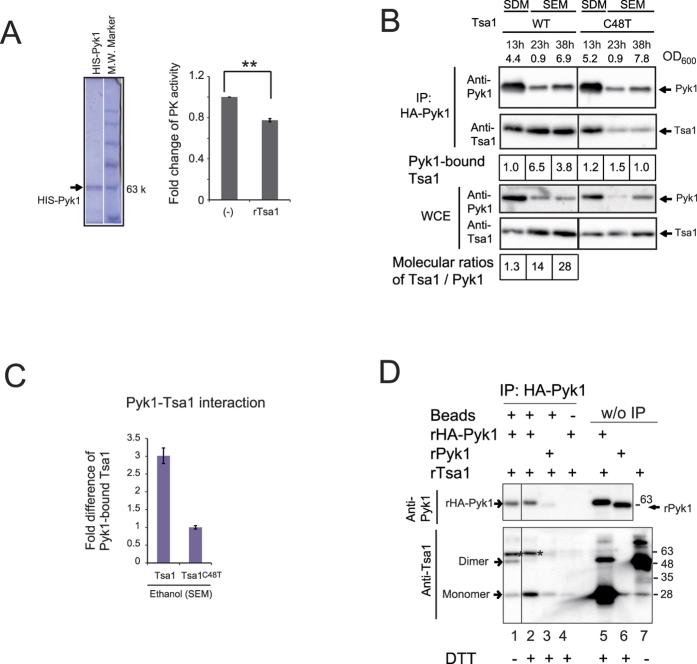
Tsa1 can bind to Pyk1 in cells during gluconeogenesis, and this interaction decreases PK activity.(A) The PK activity of purified HIS-tagged Pyk1 from yeast cells (approximately 0.8 μg), the quality of which is presented in the left panel (Quick-CBB staining), was repressed by the addition of recombinant Tsa1 (rTsa1, 1.0 μg). The fold changes in PK activity (N = 4) are reported, with error bars representing the standard error of the mean (right). “**” indicates p values of 0.0008. (B) A pull-down experiment of Tsa1 bound to HA-Pyk1. Cells expressing HA-Pyk1 and wild type Tsa1 (WT) and Tsa1C48T (C48T) were grown to the exponential phase in SDM and SEM –Trp. Cells were collected at the indicated times and cell densities (OD600; the maximum cell density in SEM was approximately 14). Immunoprecipitates and whole cell extracts (WCE) were fractionated by SDS-PAGE with DTT in sample buffer and immunoblotting. The fold differences in the levels of Pyk1-bound Tsa1 or Tsa1C48T are indicated. The molecular ratio (1.3) of Tsa1 to Pyk1 in cells growing exponentially in SDM is indicated in the data shown in Fig. 3D 32; in cells growing in SEM, this ratio was estimated by comparing the levels of Pyk1 (Tsa1) in WCE. (C) The fold difference in Tsa1 bound to Pyk1 was compared to that of Tsa1C48T. Multiple samples (N = 3) from an exponential culture (OD600 = 3) in SEM were analyzed as described in (B). (D) Detection of the interaction between the recombinant proteins was performed as described in the text (lanes 1 to 4). rPyk1 carrying no HA-tag was used as a negative control (lanes 3 and 6). IP was performed without anti-HA antibody beads (lane 4). Eluates (lanes 1 to 4) and the recombinant protein inputs (lanes 5 to 7; w/o IP) were subjected to SDS-PAGE and immunoblotting. Asterisks on the anti-Tsa1 antibody immunoblot (lower panel) indicate HIS-HA-Pyk1 that reacted with the anti-HIS tag antibody (see text). Treatments with DTT in SDS-PAGE sample buffer are indicated (lanes 2 to 6).